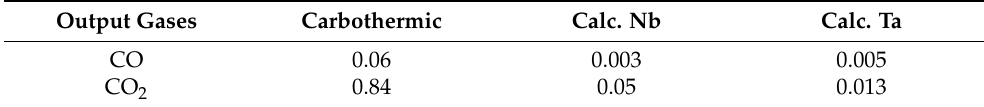
Table 4. Gases emissions per unit (in t/h).